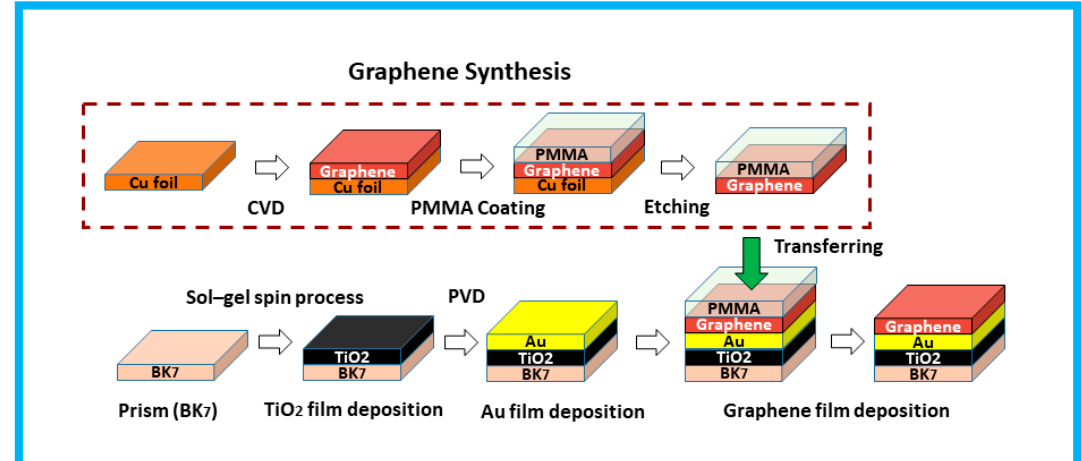
Figure 6. The proposed practical fabrication steps of the BK 7 /TiO 2 /Au/graphene structured-based biosensor.